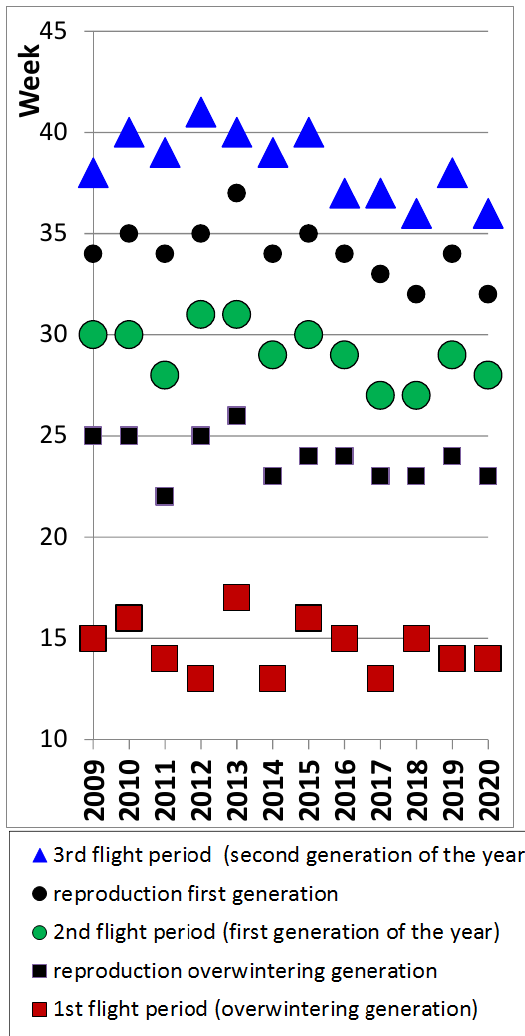
Figure 6. Summary figure with timing (median week number) of flight peaks and reproduction of peacock butterflies in Belgium 2009–2020.